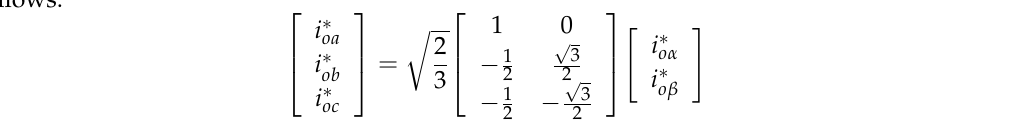
Figure 2. Control block of DSTATCOM. 3. Intelligent CFNN-AMF Controller Since the DC-link voltage of the DSTATCOM will cause a serious fluctuation and affect the performance of compensation under the load variation conditions, the DC-link voltage regulation control is very important in the compensation of power quality. However, the sluggish regulation of the DC-link voltage of DSTATCOM was obtained by the PI controller due to the unsuitable parameters for different operating conditions and the disability in dealing with the system uncertainties. Hence, for the purpose of improving the power quality and DC-link voltage regulation control of the DSTATCOM under nonlinear and linear inductive loads variation conditions, the online trained CFNN-AMF is proposed as a regulation controller to take the place of the traditional PI controller in the DSTATCOM. The network structure and online learning algorithm using the BP of the proposed CFNN-AMF are represented in detail as follows: 3.1. Network Architecture The network architecture of the proposed CFNN-AMF is shown in Figure 3a. The CFNN-AMF consists of the input layer (layer 1), membership layer (layer 2), rule and compensation layer (layer 3) and the output layer (layer 4). The compensatory characteristics are integrated into the rule layer to dynamically optimize adaptive fuzzy operations and adaptively adjust fuzzy membership functions. Thus, a superior decision can be made for the situation between the best and the worst cases [18]. The signal propagation of each layer is described in the following: